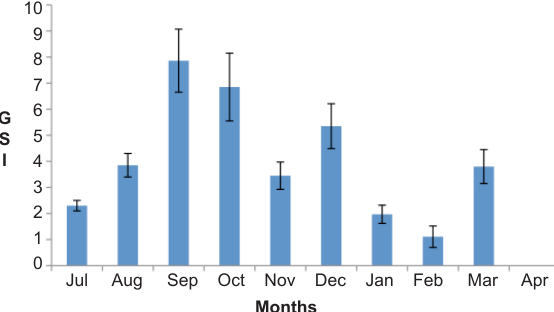
Figure 7. Monthly average of Gonado Somatic Index of female S.